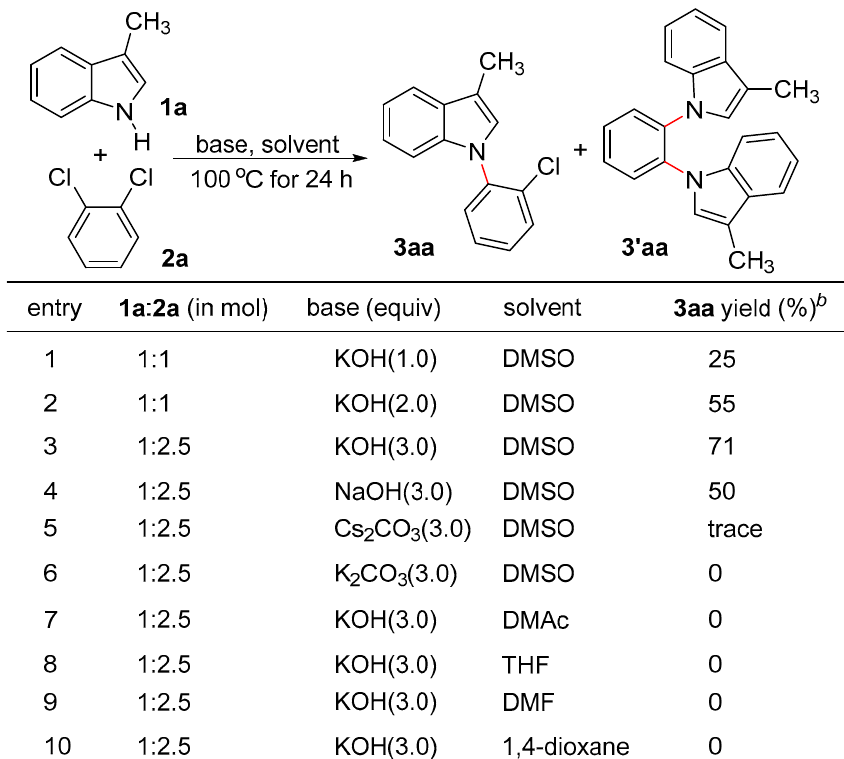
Table 1. Optimizing conditions for the nucleophilic aromatic substitution of 3-methylindole ( 1a ) with 1,2-dichlorobenzene ( 2a ) a .